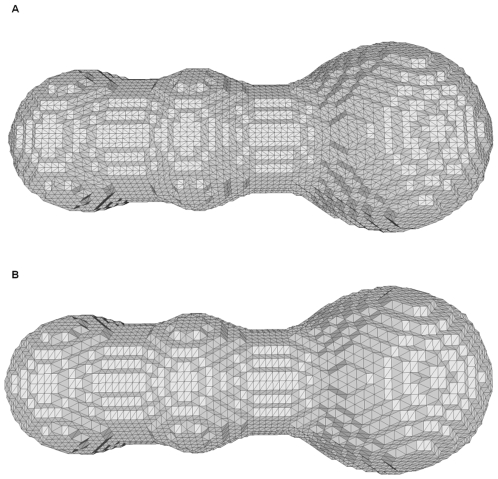
Molecular surfaces of three atoms at the resolution 1283.(A) generated by EDTSurf-MC; (B) generated by EDTSurf-VCMC.